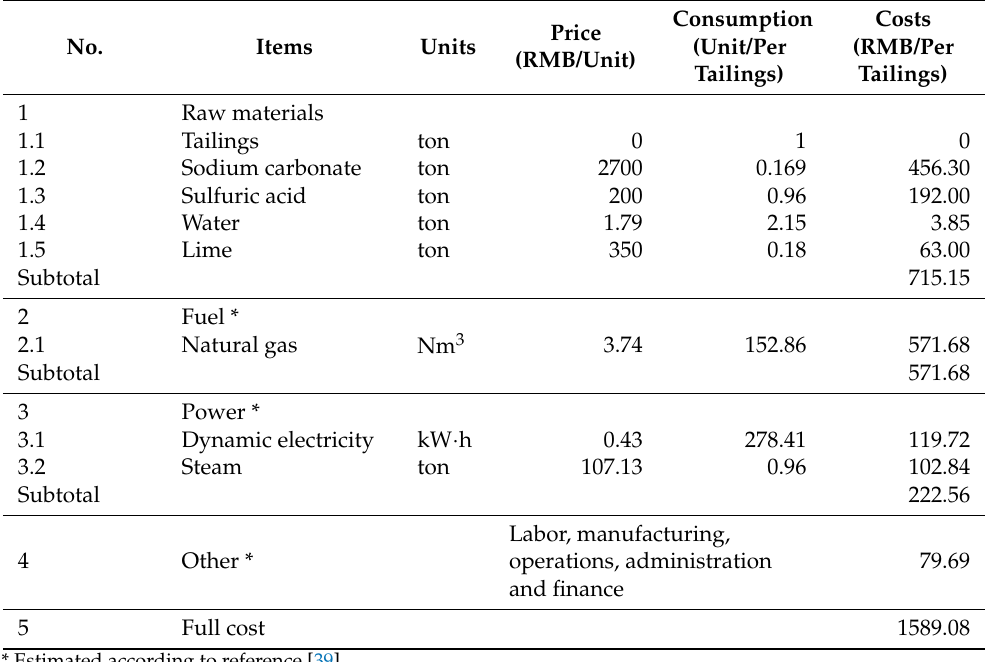
Table 4. Cost estimation of processing per ton of silver tailings.